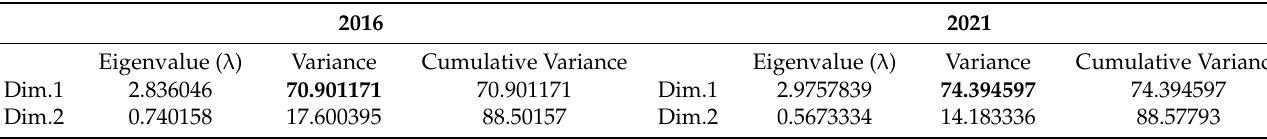
Table 5. Eigenvalue and variance proportions.